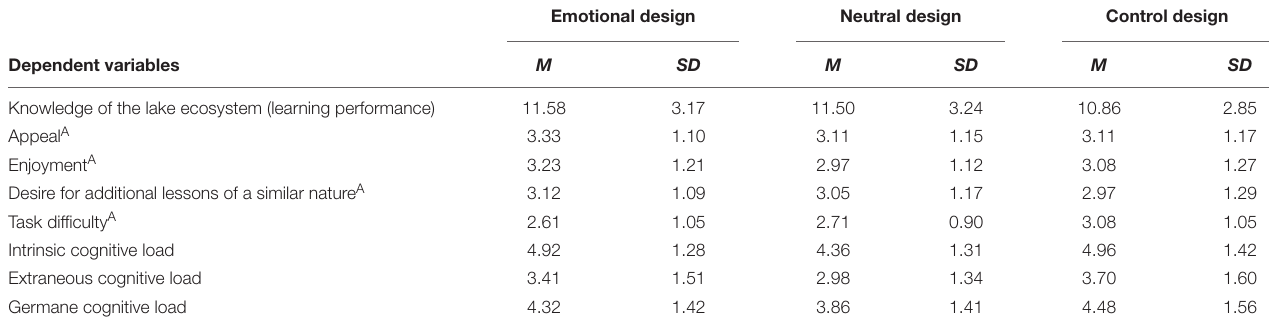
TABLE 1 | Means and standard deviations of dependent